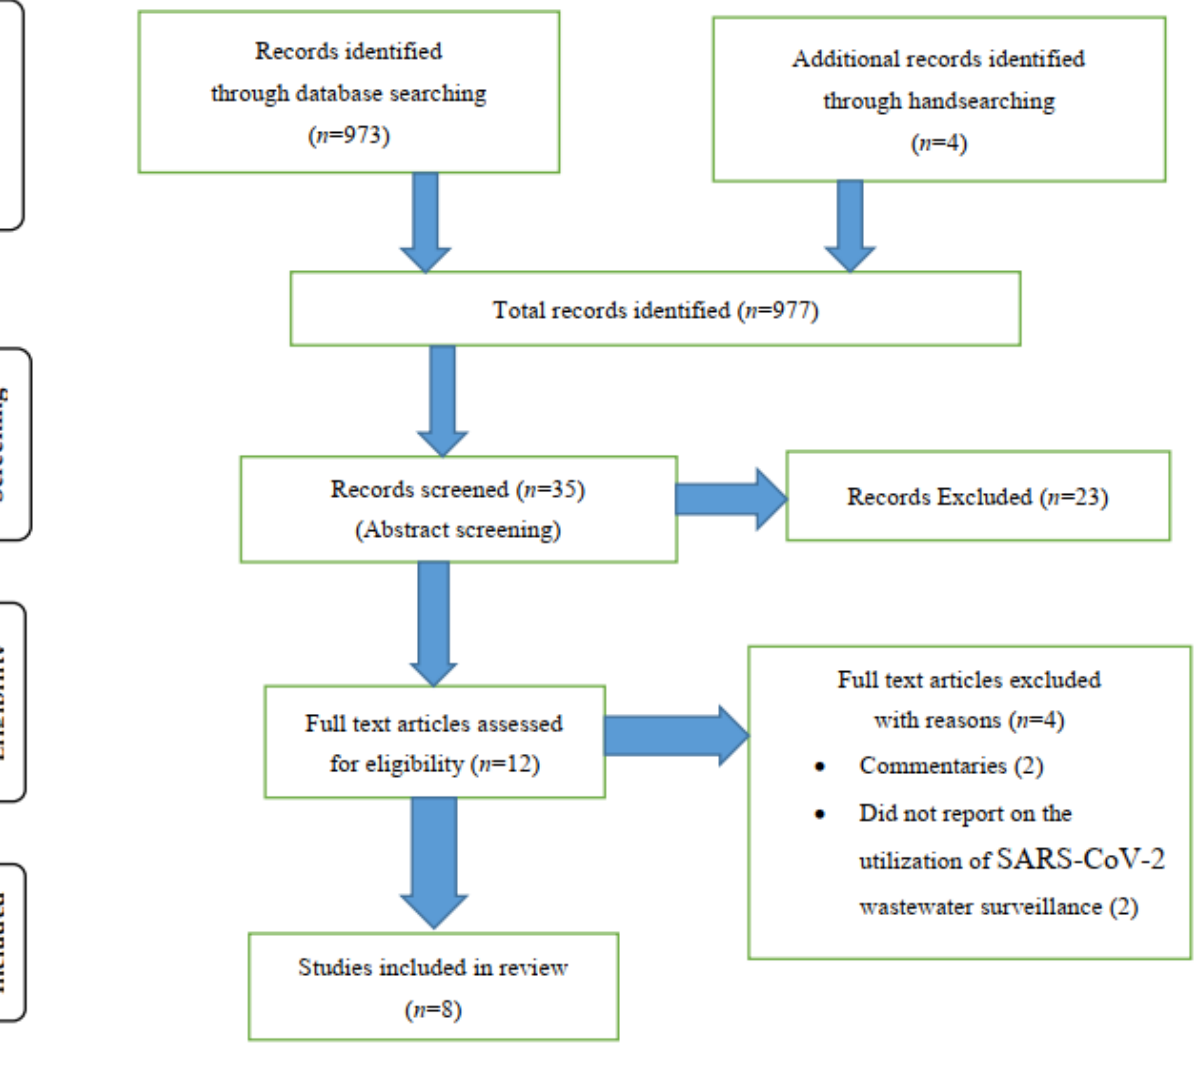
Figure 1. PRISMA flow diagram.